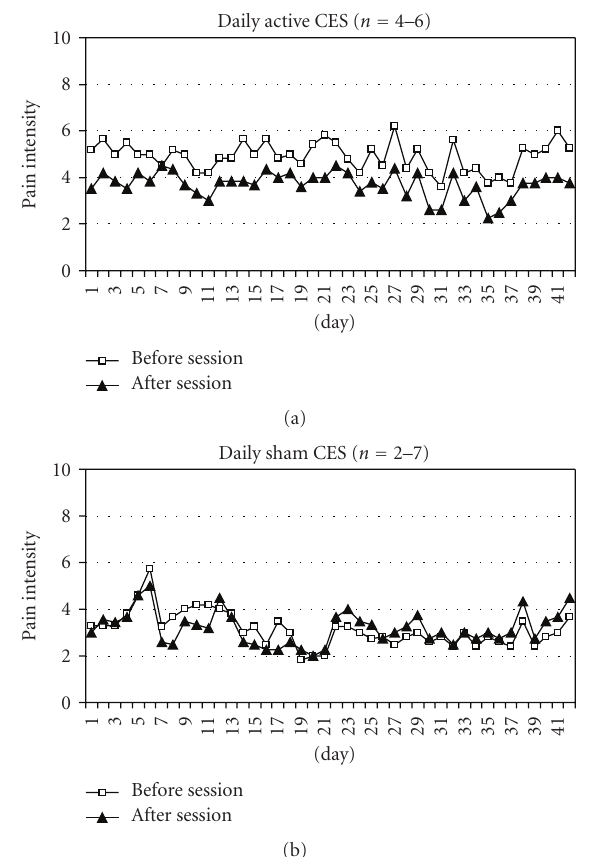
Figure 2: Average daily pain ratings before and after CES sessions for active and sham